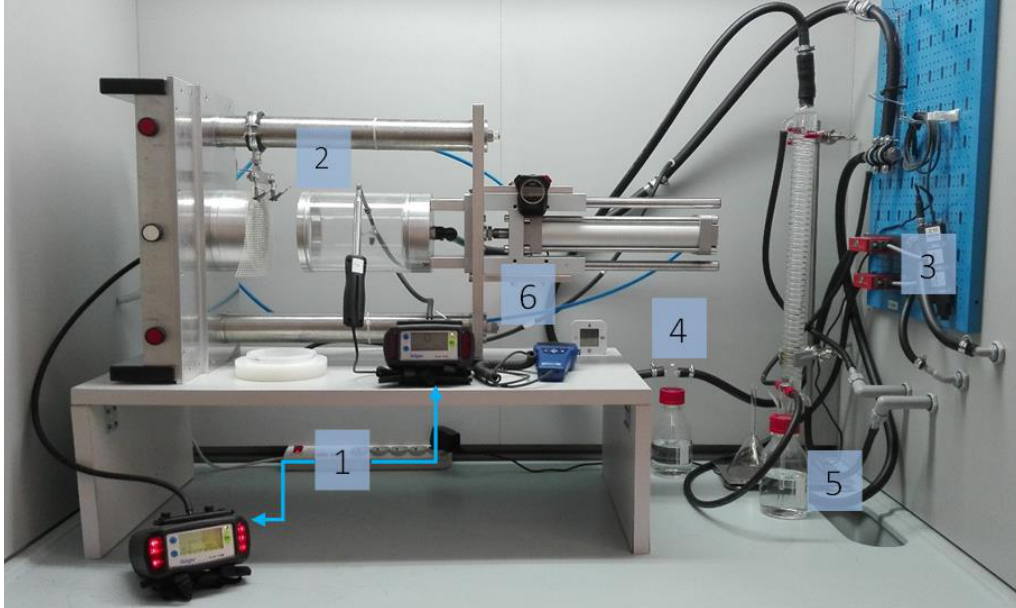
Figure 1. Experimental stand for measuring the sorption capacity of volatile compounds for flat textile products: 1 – gas analyzers, 2 – pneumatic test chamber, 3 – airflow control system,4 – humidifier, 5 – evaporator, 6 – thermohygrometer.